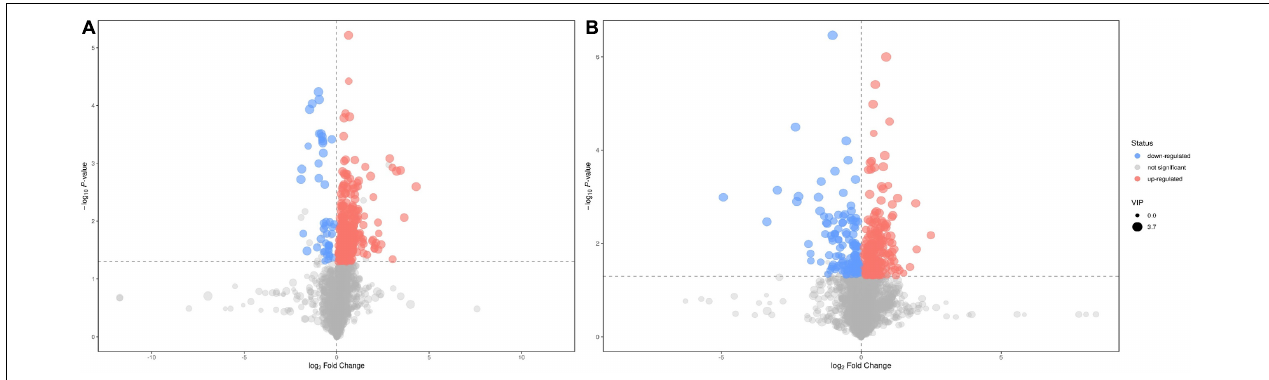
FIGURE 3 | Volcano plots of differential features of metabolites between the EA group and the non-EA group. 428 features in the negative mode (A) and 363 features in the positive mode (B) were selected using the criteria of VIP > 1 and p < 0.05. As shown in the volcano plots, the increased and decreased features were marked as red and blue, respectively. TABLE 3 | Differentially expressed metabolites in the serum of EA and non-EA patients under general anesthesia.